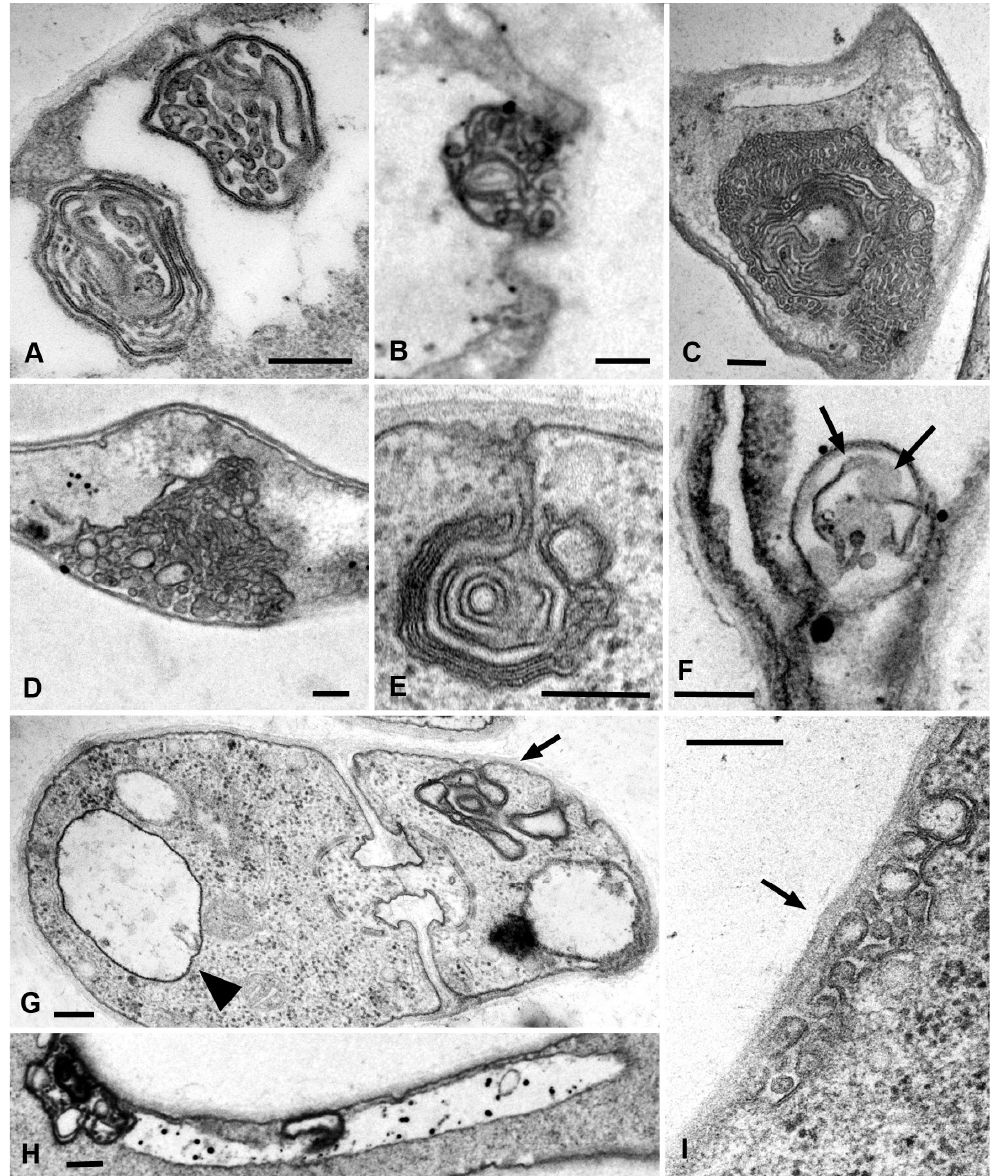
Figure 9. Transmission electron microscopic images of various types of lomasomes in xylotrophic basidiomycetes corresponding to various AM4-64 labeled PM macroinvaginations. ( A )—classic lamel- lar (bottom) and vesicular (tubular, top) lomasomes corresponding to glomeruli ( P. luminescens ). ( B )—lomasome (glomerulus) consisting of intertwined thin tubules ( L. edodes ). ( C )—a complex lo- masome consisting of ordered tubules and lamellae corresponds to a large glomerulus ( P. stipticus ). ( D )—a complex vesicular (tubular) lomasome also corresponds to a large glomerulus ( P. luminescens ). ( E )—a lamellar lomasome on a short stem corresponds to the pendant ( L. edodes ). ( F )—a lamellar-tubular lomasome ( S. hirsutum ); it can be seen how the lamellae damaged during cutting turned their flat side into the section plane (arrows). ( G )—a section through a dolipore septum ( L. edodes ); the arrow indicates the lamellar lomasome beginning to form; the arrowhead indicates the small vesicle. ( H )—the thin longitudinal tube pressed against the PM at the ultrastructural level ( L. edodes ). ( I )—a vesicular (tubular) lomasome corresponding to the small plaque ( P. luminescens ). Scale bars are 200